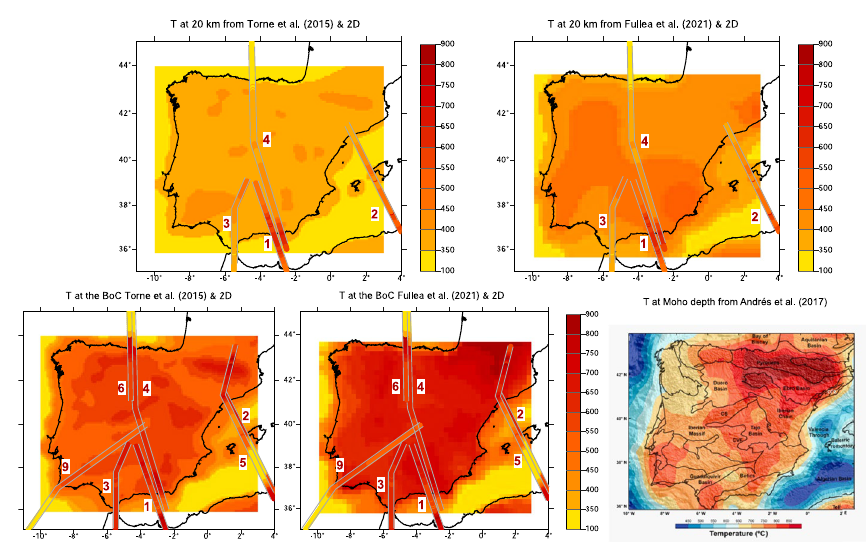
Fig. 7 Temperature distribution at 20 km crustal depth and at the Moho based. on the regional models of Torne et al. (2015) and Fullea et al. (2021) and the 2D profiles of: at 20 m depth: Kumar et al. (2021) (1 and 2); Jiménez‑Munt et al. (2019) (3); Carballo et al. (2015a) (4). At Moho depth we have added data from Pedreira et al. (2015) (6) and Fernàndez et al. (2004) (9). T at the Moho from Curie Depth Point of Andrés et al. (2018) is shown for comparison